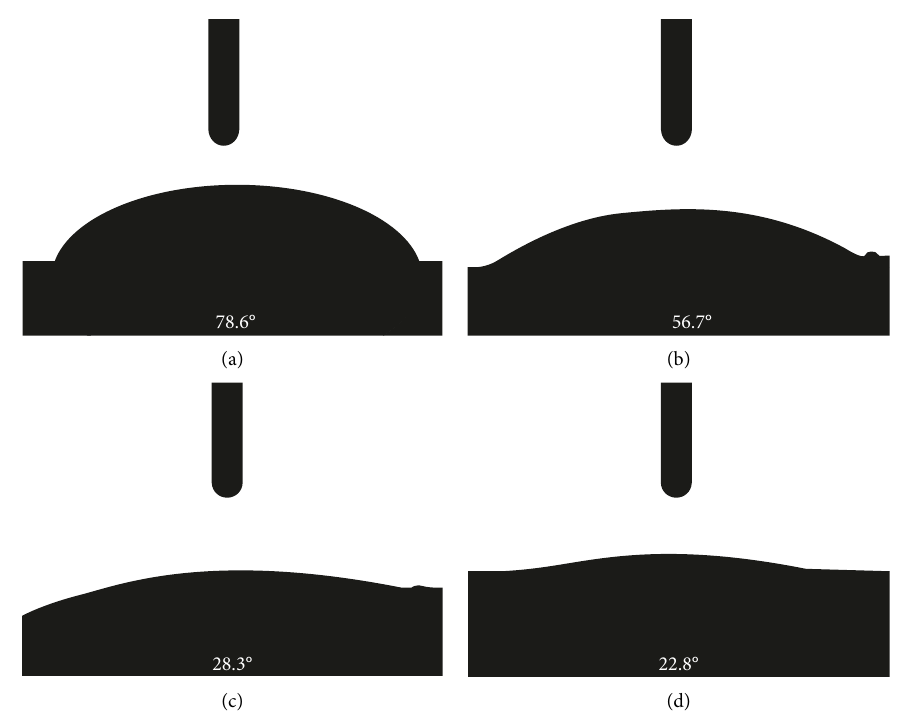
Figure 6: Contact angle measurement of (a) the alkali-treated Ti alloy, (b) PEDOT-HNT composite-coated Ti alloy, and (c) PEDOT- HNT/CS-HA and (d) PEDOT-HNT/CS-MHA bilayer composite-coated Ti alloy. In vitro biological studies of the bilayer